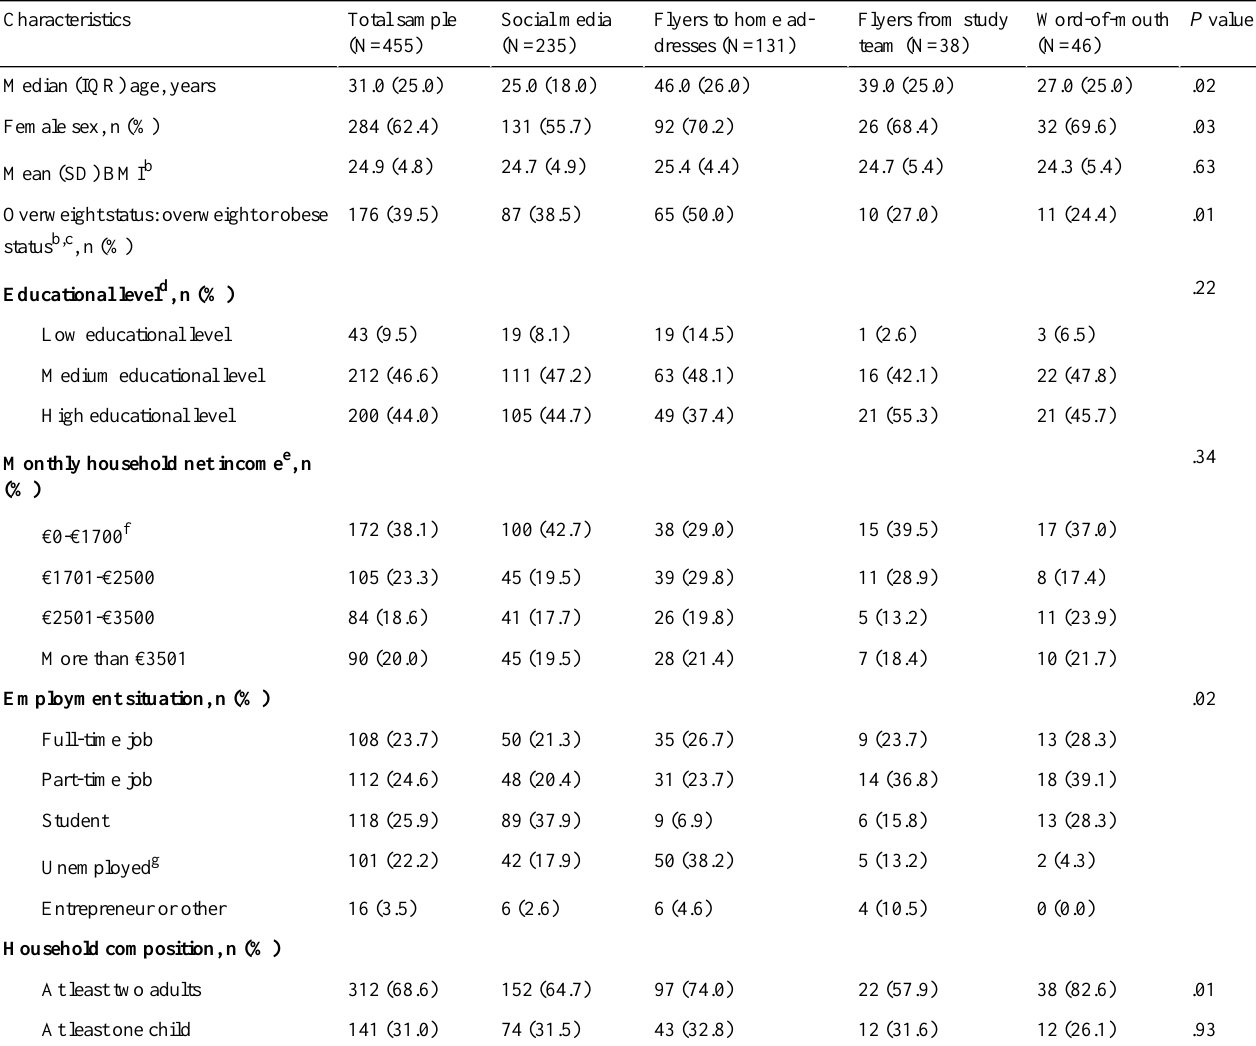
Table 4. Characteristics of the study population for the entire sample and stratified by recruitment strategy. a